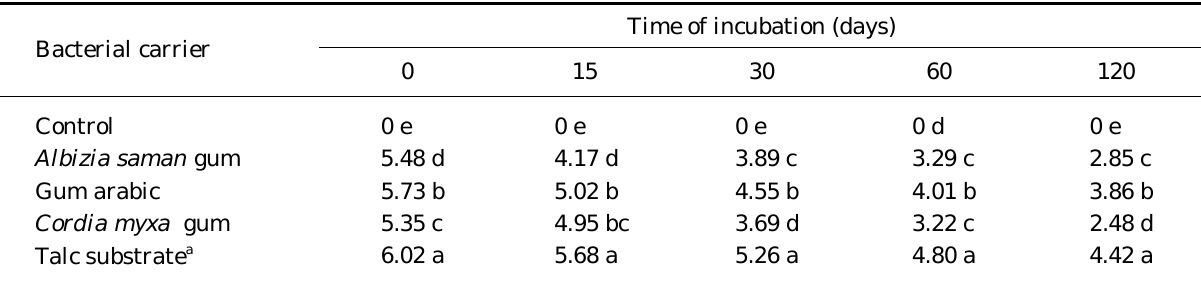
Table 1. Survival of Pseudomonas aeruginosa on mungbean seeds after coating with various carrier materials to which a 10 8 cfu/ml suspension of the bacterium had been mixed. Bacterial concentration per seed is expressed as (x+1) cfu per seed. log 10